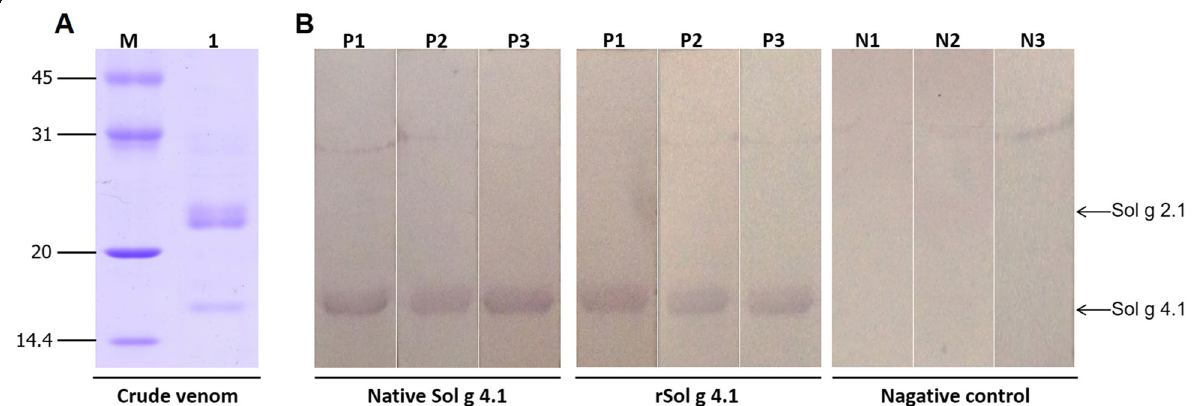
Fig. 6 Allergenic analysis of native and recombinant Sol g 4.1 with anti-Sol g 4.1 IgE antibody. a Crude venom expression pattern, as determined by SDS-PAGE. b Determination of the allergenic properties of the Sol g 4.1 protein by producing an antiserum in mice and analyzing the product using Western blotting. Recognition of native Sol g 4.1 and rSol g 4.1 proteins by serum IgE in Sol g 4.1 protein-sensitized mice. Serum samples: P1-P3 = individual sera of Sol g 4.1 protein-sensitized mice; N1-N3 = serum from mice injected with PBS, acrylamide gel and adjuvant, respectively, as controls